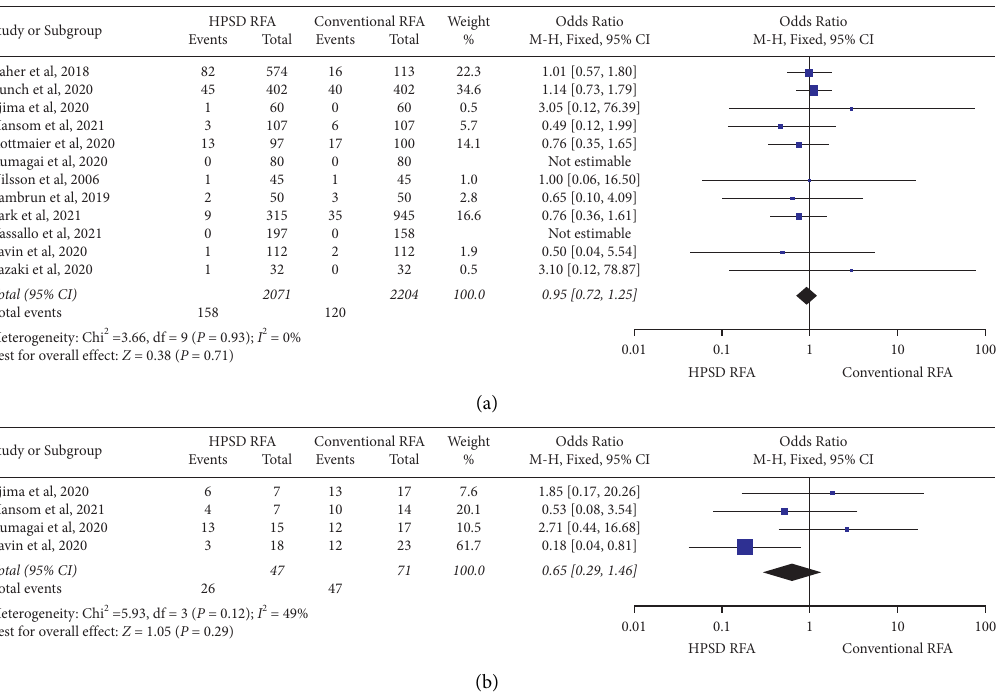
Heterogeneity: Chi 2 =5.93, df = 3 ( P = 0.12); I 2 = 49% Test for overall effect: Z = 1.05 ( P =